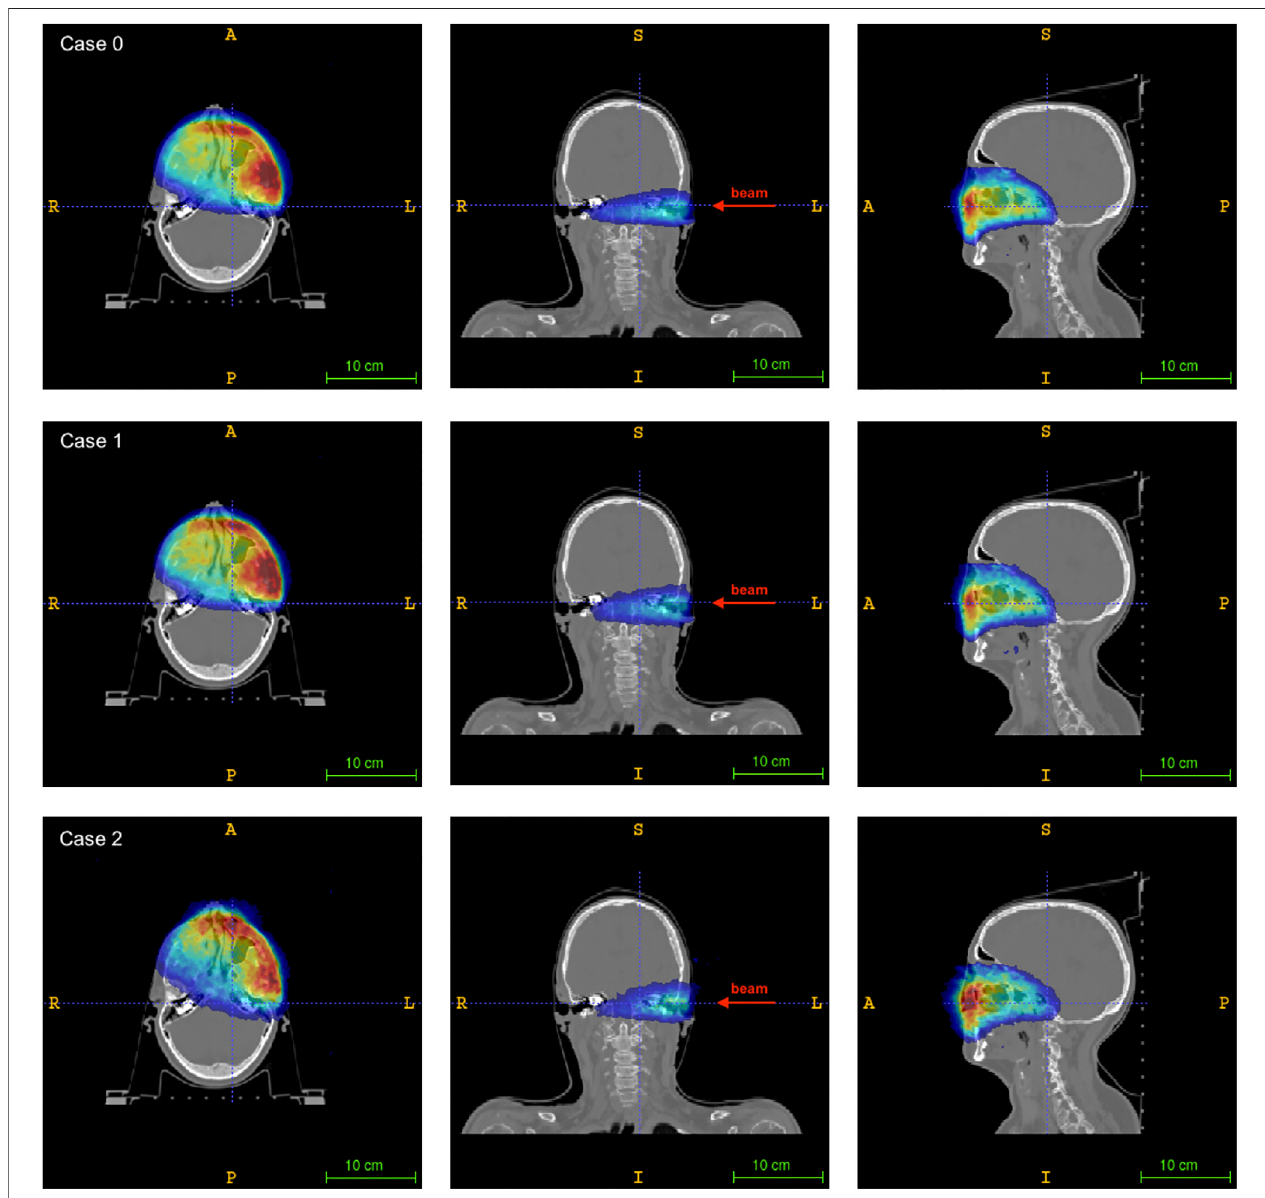
FIGURE 7 | Axial (left) , coronal (center) and sagittal (right) sections of the patient CT superimposed to the reconstructed activity distributions for the different geometries: case 0 (upper row) , case 1 (central row) , case 2 (lower row) . The activity maps are normalized to their maximum intensity. The beam direction is shown for the coronal slice. A standard RAI coordinate system is considered.